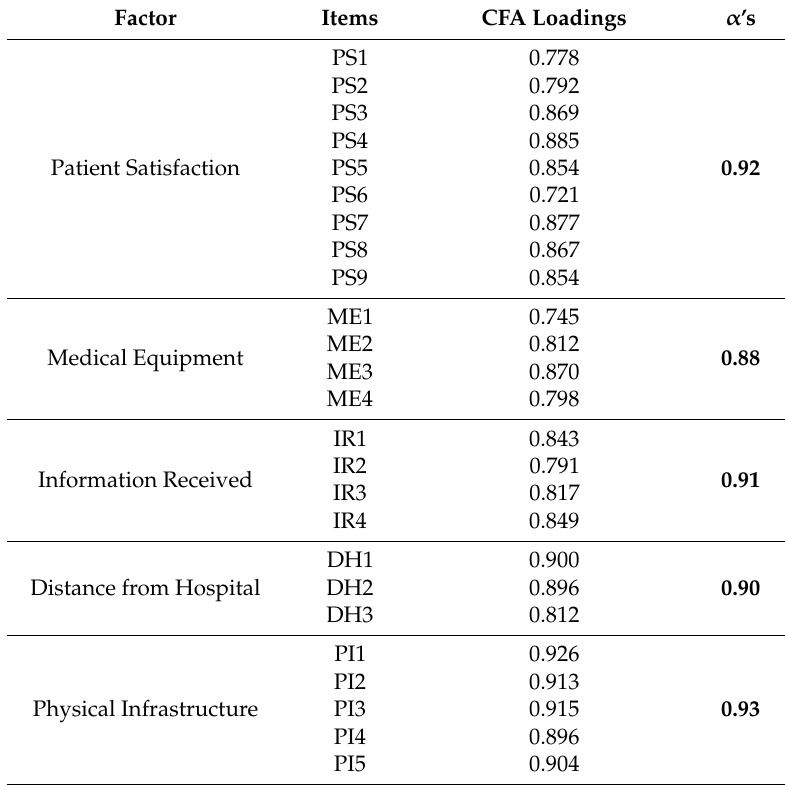
Table 7. Confirmatory factor analysis (CFA).